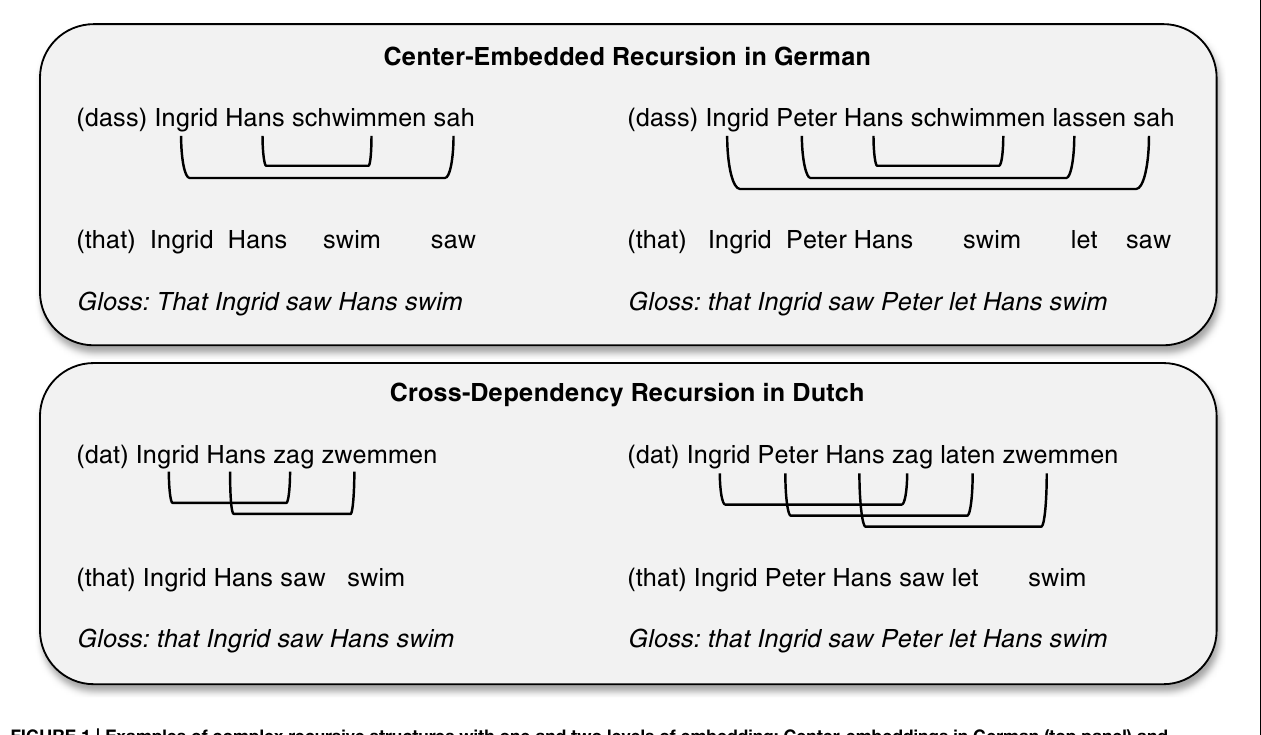
FIGURE 1 | Examples of complex recursive structures with one and two levels of embedding: Center-embeddings in German (top panel) and cross-dependencies in Dutch (bottom panel). The lines indicate noun-verb dependencies.